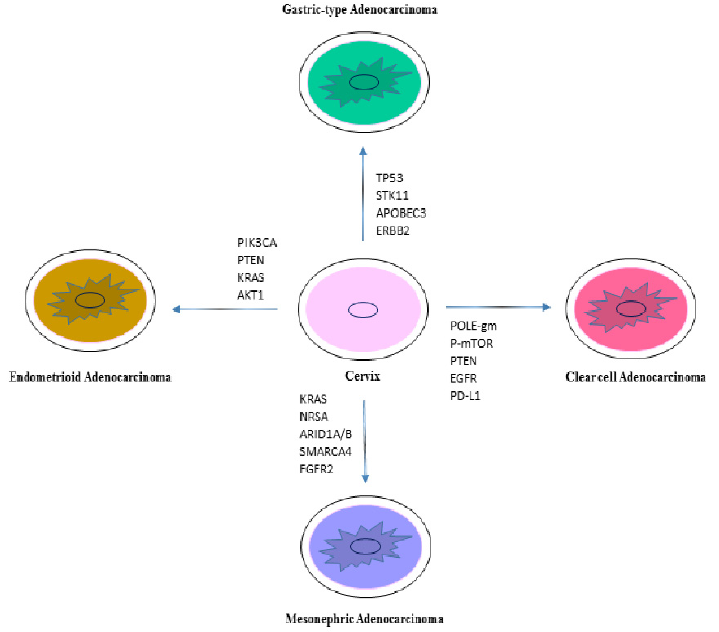
Figure 1. Main gene mutations in different HPV-negative cervical